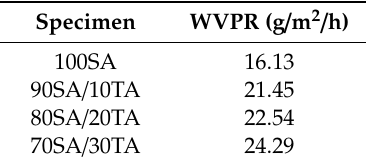
Table 4. Water permeability (WVPR) of films based on sodium alginate and tannic acid. Specimen